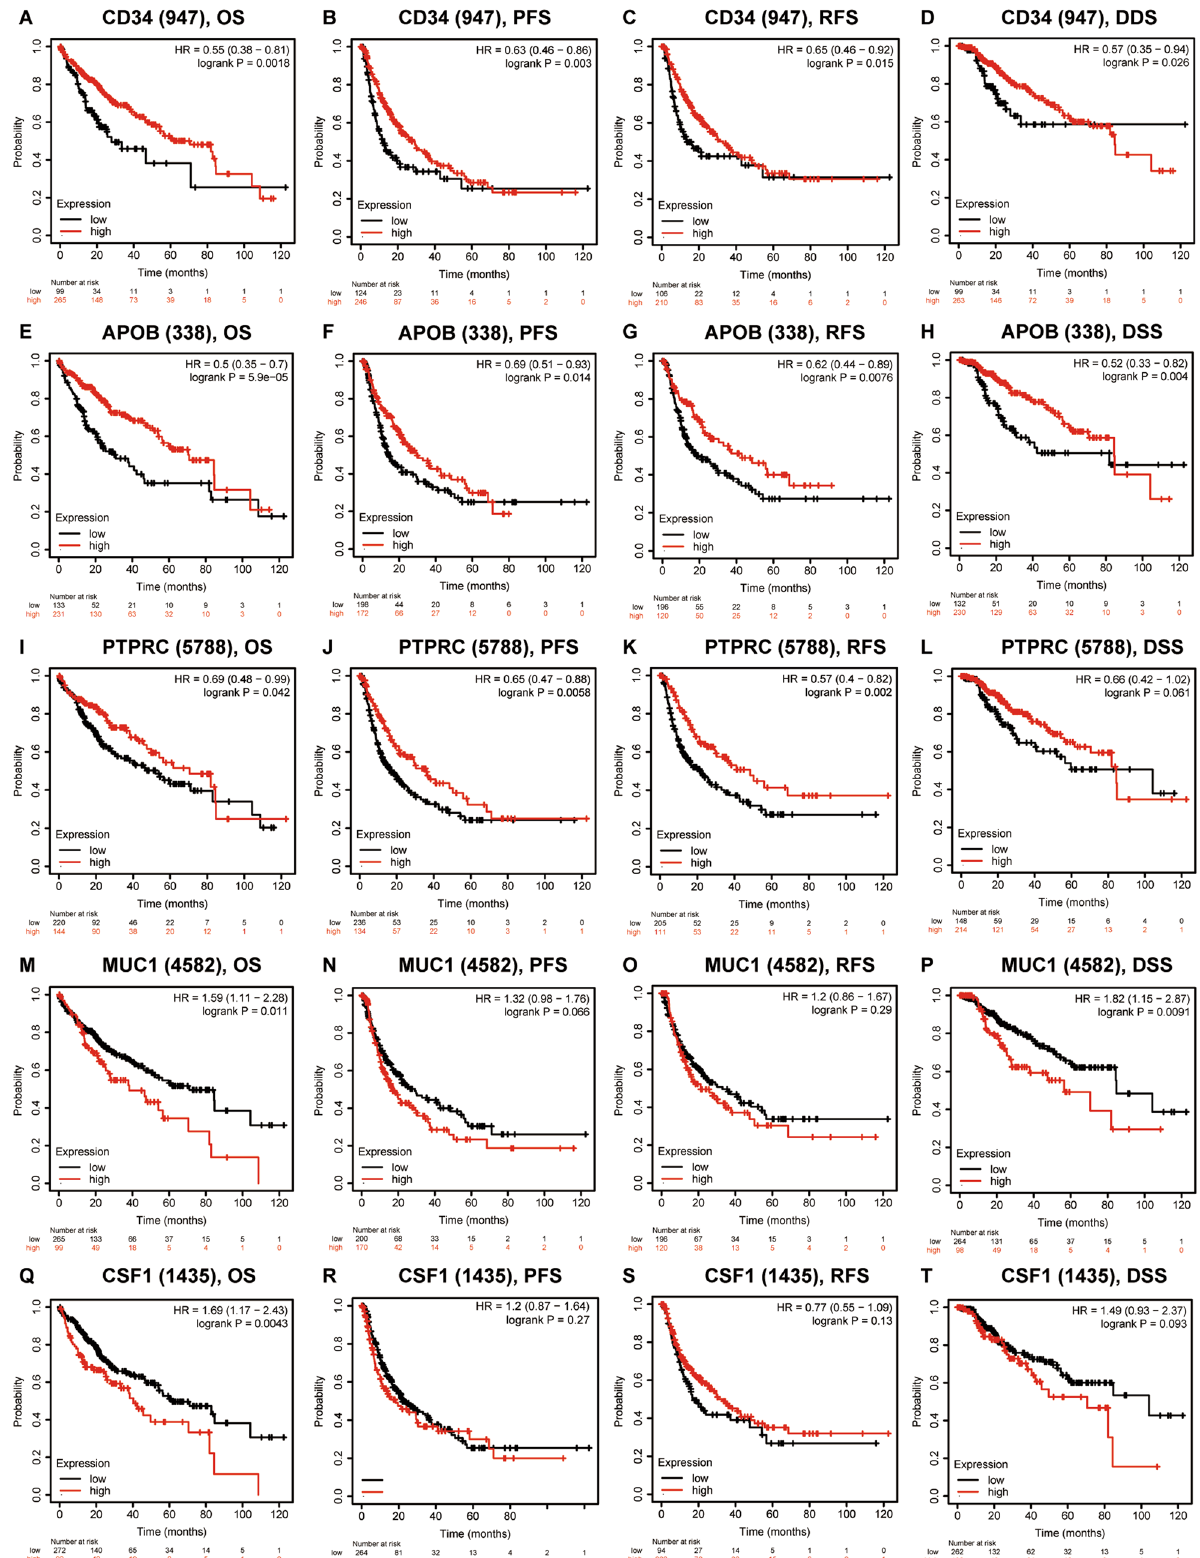
Figure 10. The prognostic value of hub genes in HCC patients. ( A – D ) CD34, ( E – H ) APOB, ( I – L ) PTPRC, ( M – P ) MUC1, ( Q – T )